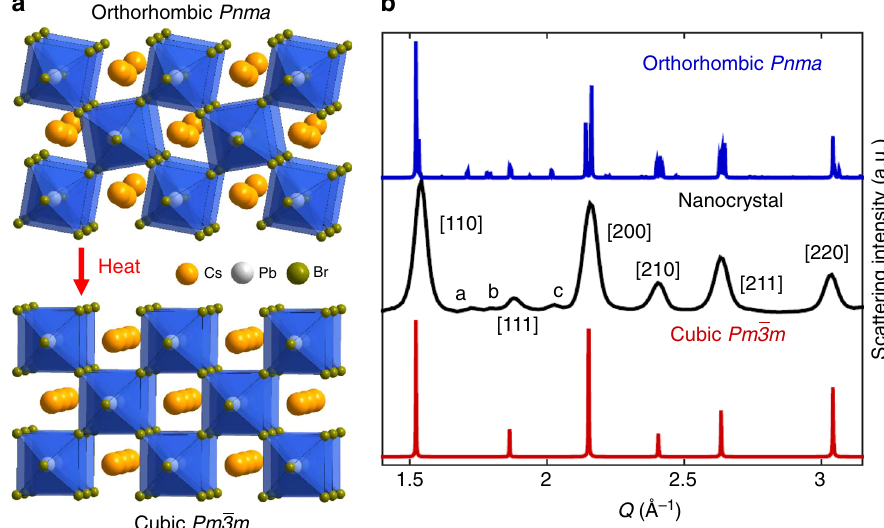
Fig. 1 Comparison of orthorhombic and cubic phases. a Schematic of CsPbBr 3 in the orthorhombic (top) and cubic phases (bottom). b XRD patterns for the orthorhombic (blue) and cubic phases (red) as generated with VESTA along with the experimental NC XRD pattern (black). The bulk crystal structures are based on a CIF data from Stoumpos et al. 22 which were adapted with permission. Copyright 2013 American Chemical